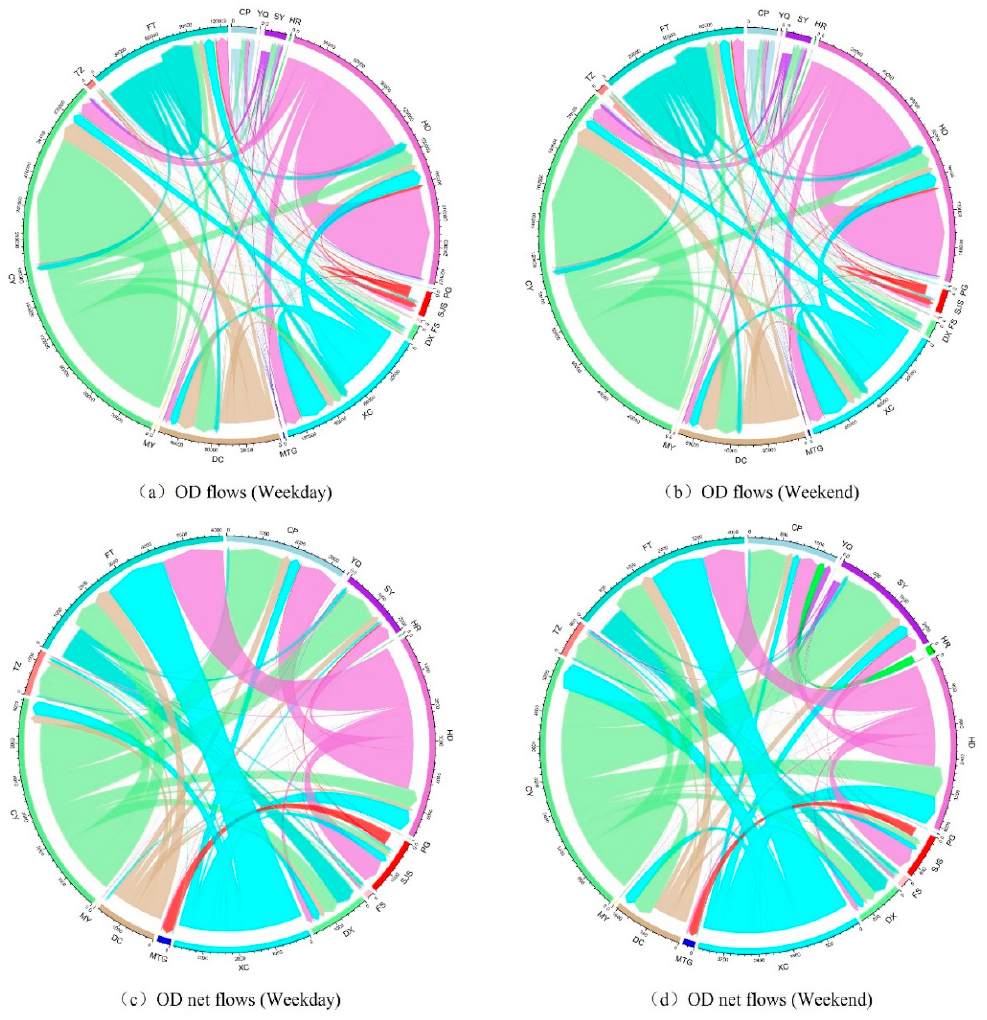
Figure 13. OD flows in various regions of Beijing based on the chord diagram plot.